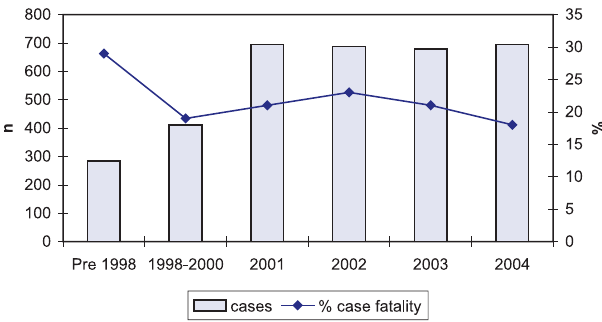
Figure 1. Annual Admissions of Children with Severe Malnutrition and Case Fatality Rates Prior to 2000, malnutrition was defined as weight for age (WAZ) less than (cid:1) 4 or oedematous malnutrition. Annual admissions rates: